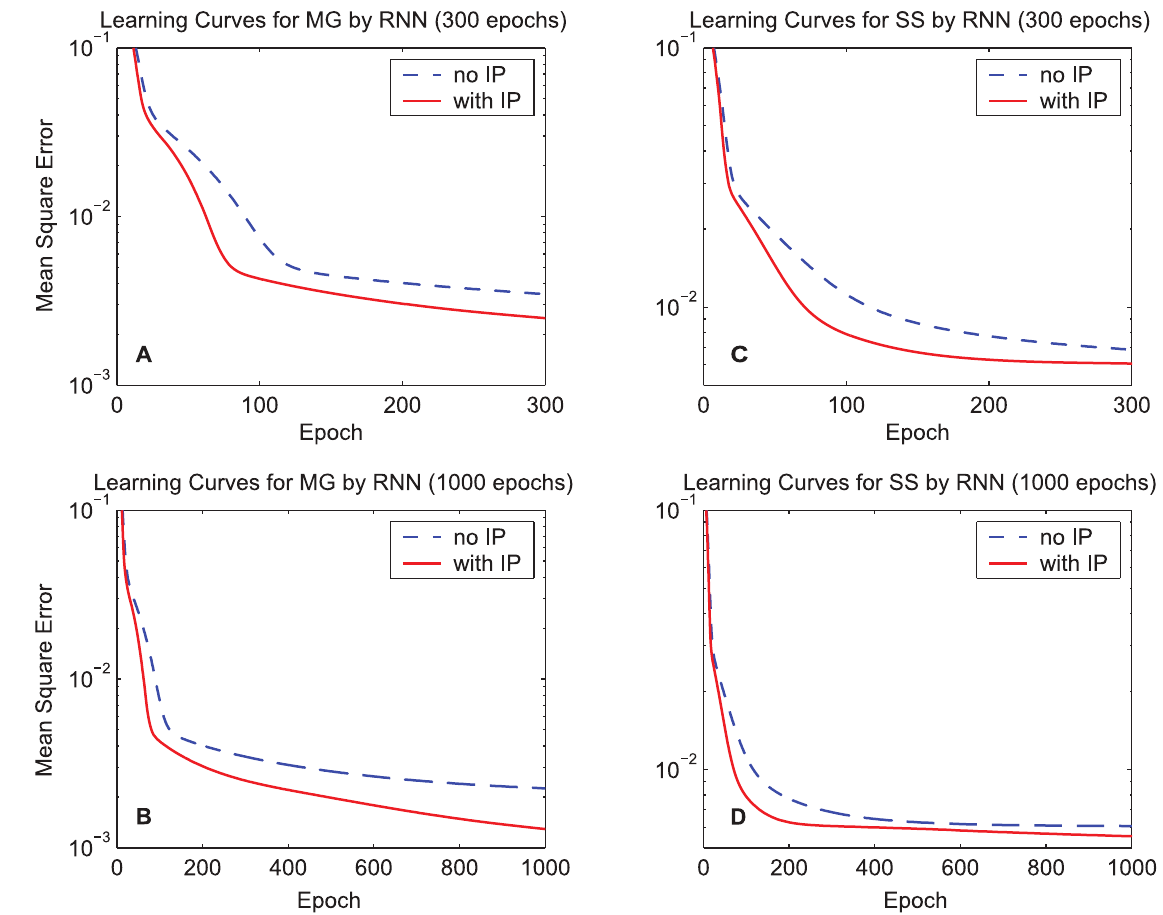
Figure 12. Learning curves of the mean square error by the RNN. The dashed lines denote the learning curves of the MEE algorithm, and the solid lines denote the learning curves of the synergistic algorithm. (A) 300-epoch learning curves for the training data set ‘‘MG’’. (B) 1000-epoch learning curves of ‘‘MG’’. (C) 300-epoch learning curves for the training data set ‘‘SS’’. (D) 1000-epoch learning curves of ‘‘SS’’.